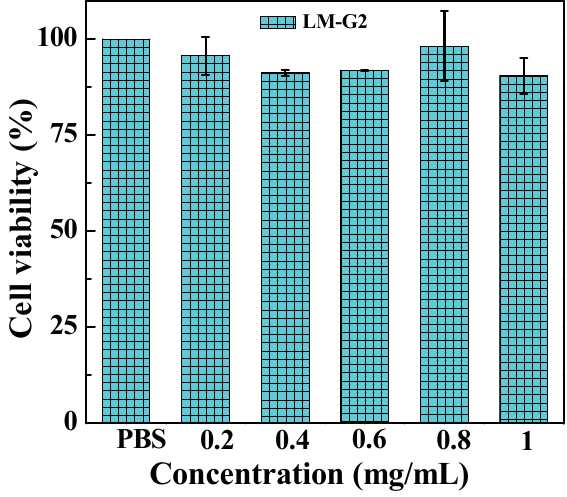
Figure 6. Viability of KB cells treated with LM-G2 nanodisks at a concentration of 0.2, 0.4, 0.6, 0.8, and 1.0 mg/mL for 24 h at 37